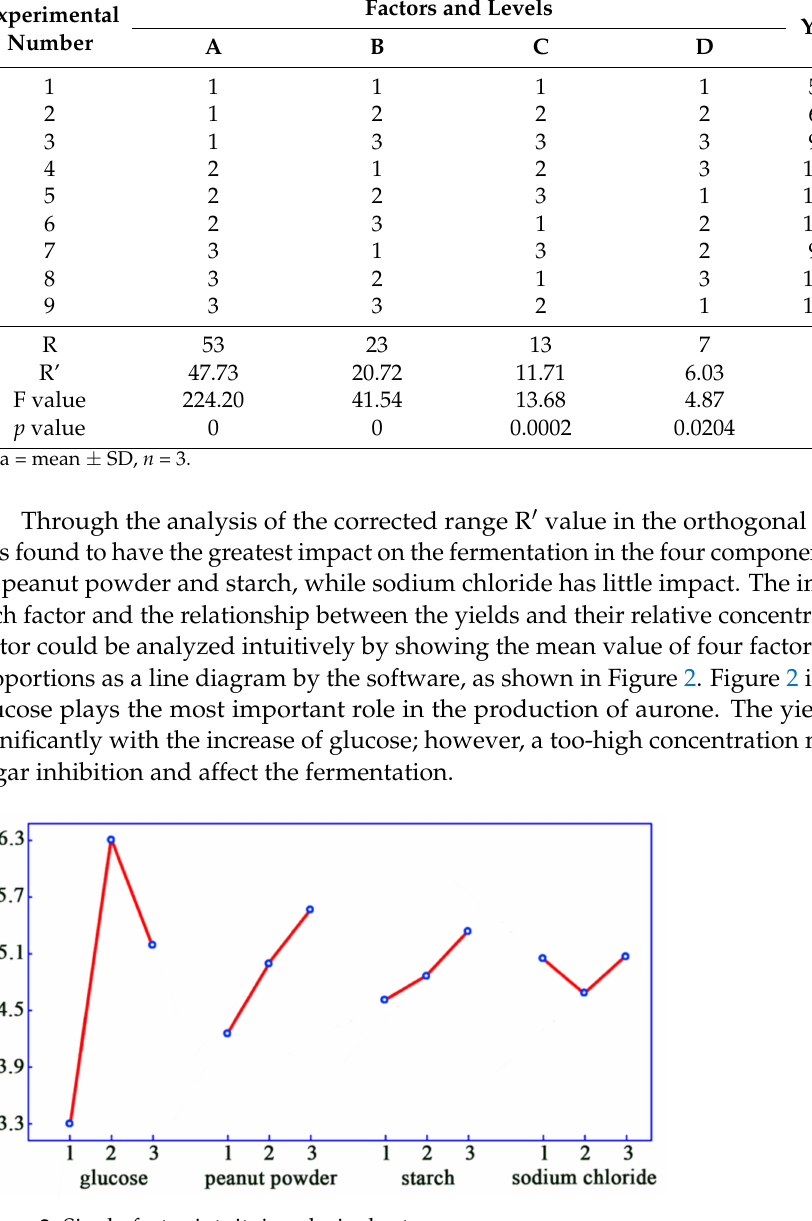
Figure 2. Single-factor intuitvie anlysis